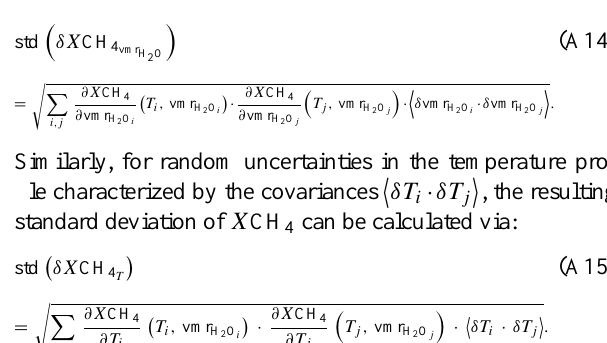
Fig. A1. Optical depth of methane around the most favorable methane line multiplet at 1645.6nm (thick solid; zoom of Fig. 3) and weighting function figure of merit (dotted). Colored: Relative X CH 4 uncertainty in ‰ due to temperature profile uncertainties as function of on-line wavenumber for six representative climates (black: US standard, red: tropical, orange: mid-latitude summer, green: mid-latitude winter, blue: sub-arctic summer, yellow: sub- arctic winter), normalized by the weighting function figure of merit. Vertical dashed line: position of nominal on-line wavelength ac- cording to Table 1.